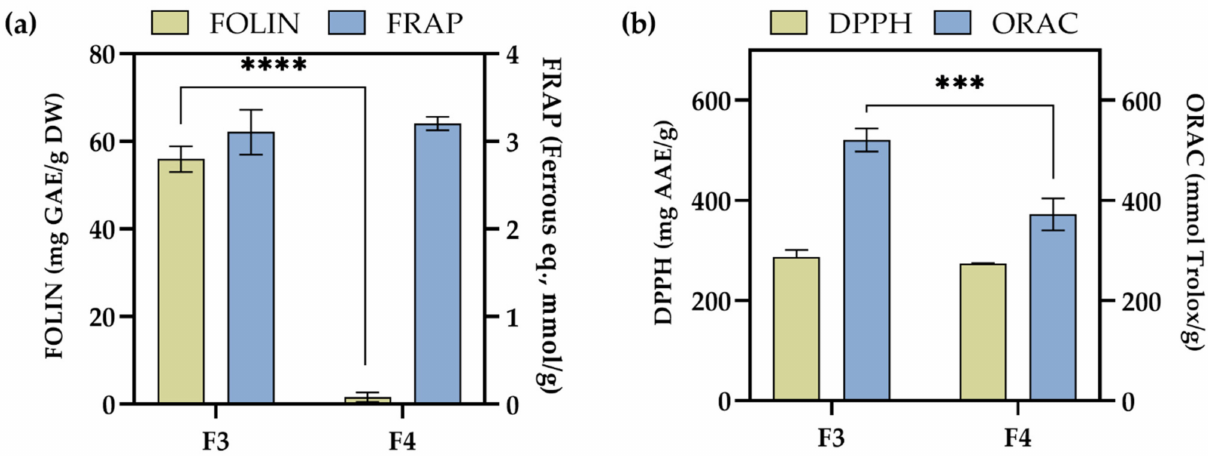
Figure 6. Scavenging radical activity of two fractions of D. vermicularis (F3 and F4) obtained using ( a ) Folin–Ciocalteu method and ferric reducing antioxidant power (FRAP), and ( b ) 2,2-diphenyl-1- picrylhydrazyl (DPPH) assay and oxygen radical absorbance capacity (ORAC) (mean ± SD; n = 4). An asterisk indicates a significant difference between F3 and F4 (*** p < 0.001; **** p <